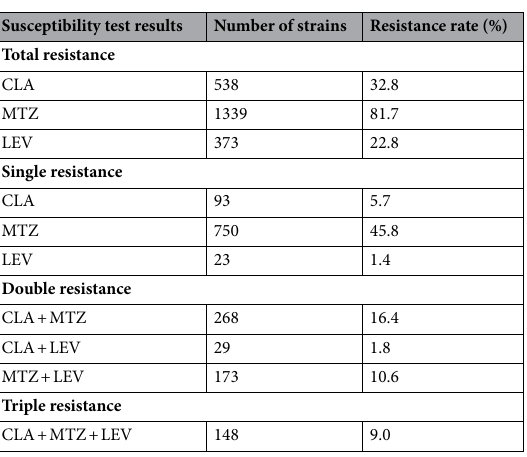
Table 2. Results of antibiotic susceptibility tests of 1638 H. pylori strains isolated from 2015 to 2020. CLA, clarithromycin; MTZ, metronidazole; LEV,